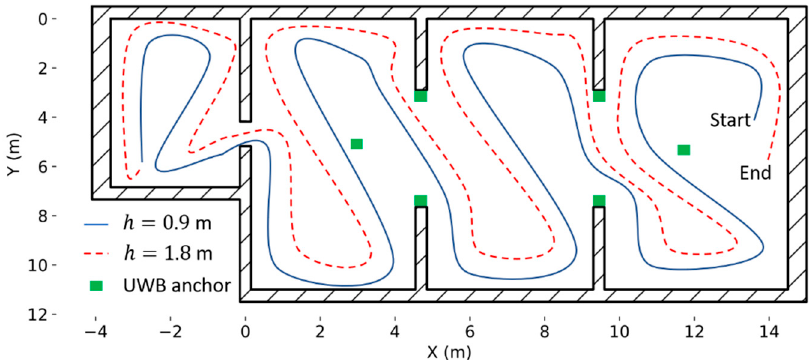
Figure 9. Predefined navigation strategy based on zig-zag sweeping at two heights (0.9 and 1.8 m). The green squares indicate the location of the UWB anchors.